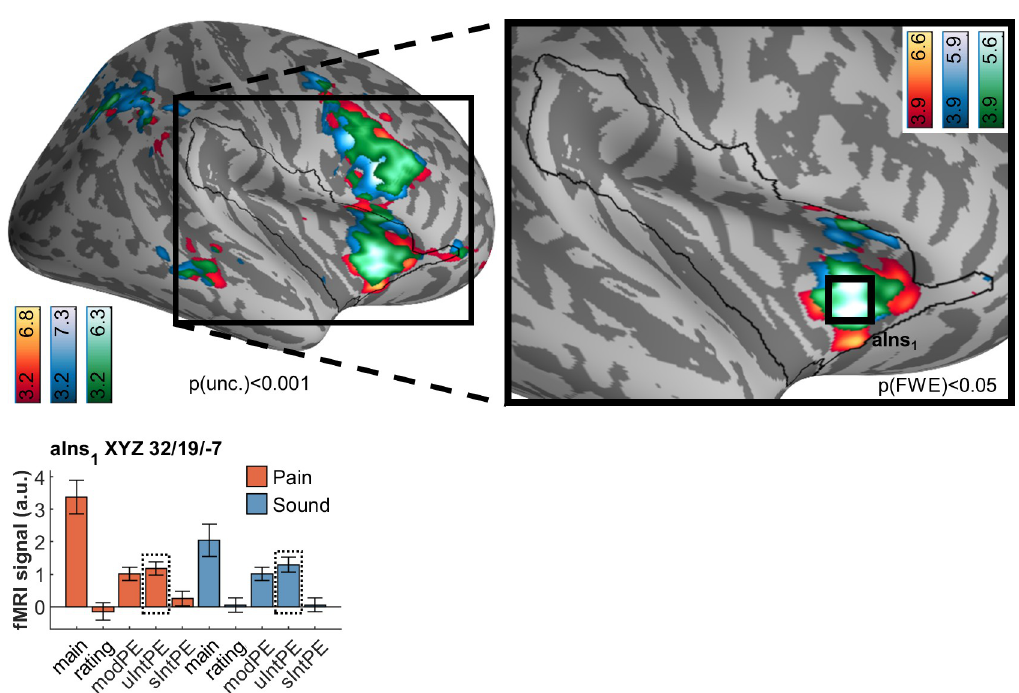
Fig 6. Brain activation following unsigned intensity prediction errors in pain (red/yellow) and sound (blue), including overlaps as per conjunction analyses (green). Peak activation following either modality is located in the anterior insula (aIns 1 ) and is subsumed in the common activation. Activations are overlaid on an average brain surface; for display purposes, activations in the whole brain lateral view are thresholded at p[uncorr.] < 0.001. The black line in the zoomed-in view delineates the region of interest and includes activations within the small volume FWE corrected at p[corr.] < 0.05. See Supporting information for peak positions in whole brain (S8 Fig) and brain volume slices (S9 Fig). In the fMRI signal bar graph, black rectangles highlight the regressors used for analysis; solid line indicates analysis with the respective individual regressor, and dashed line indicates conjunction analysis. fMRI signal labels refer to the regressors used for each modality: “main” for main effects of modality, “ratings” for behavioral ratings, “modPE” for modality PEs, “uIntPE” for unsigned intensity PEs, and “sIntPE” for signed intensity PEs. Data used to produce the figure can be found at https://www.doi.org/10. 17605/OSF.IO/7JBV3. fMRI, functional magnetic resonance imaging; FWE, family-wise error; PE, prediction